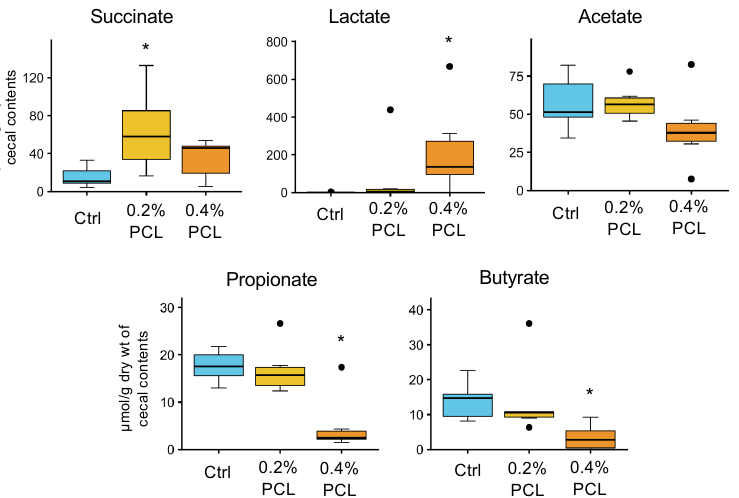
Figure 5. Effects of supplemental PCL on cecal levels of organic acids. * p < 0.05 means significantly different when compared to the Ctrl group (Dunnett’s test). Data are presented as a boxplot with median and min–max whiskers. The dots ( • ) in the boxplots are